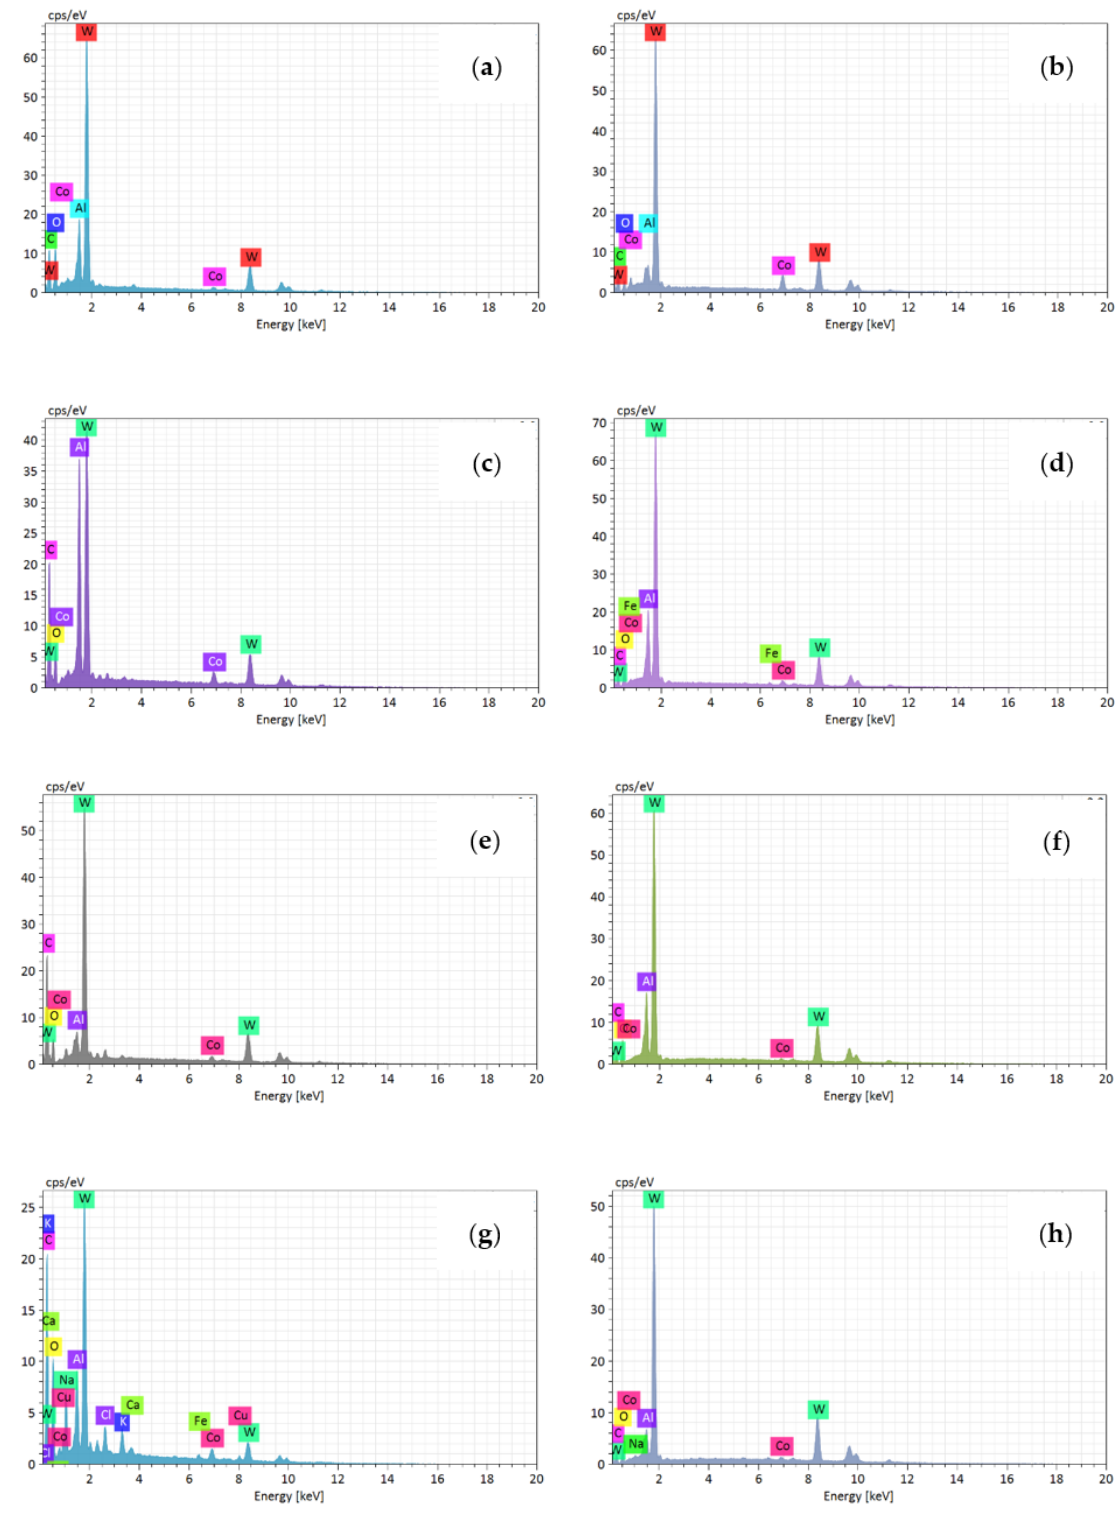
Figure 11. The EDS results of flank face wear morphology at different feed (( a – h ) represent the points A~H in the Figure 10 respectively).